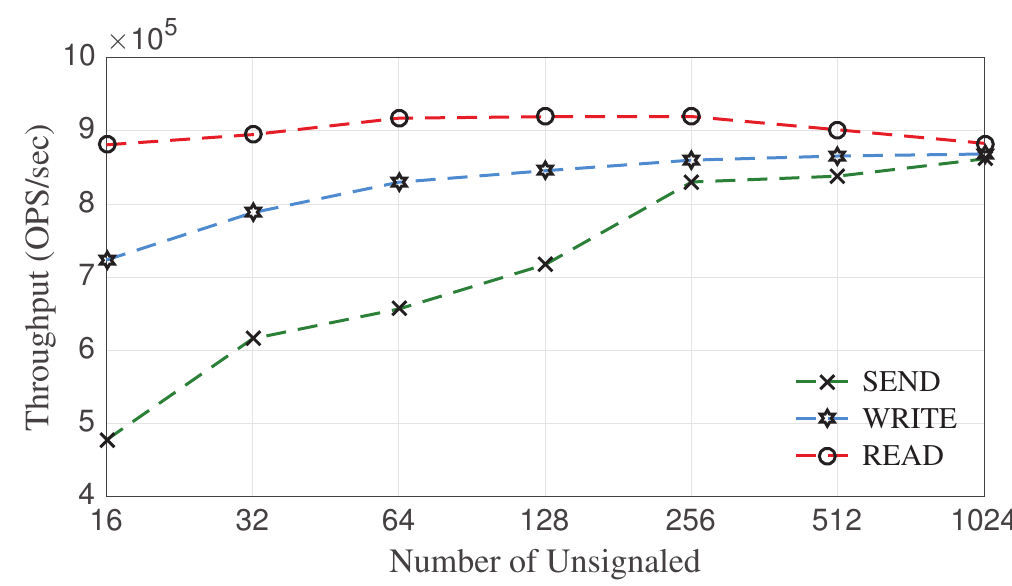
Figure 7. Unsignaled operations impact on